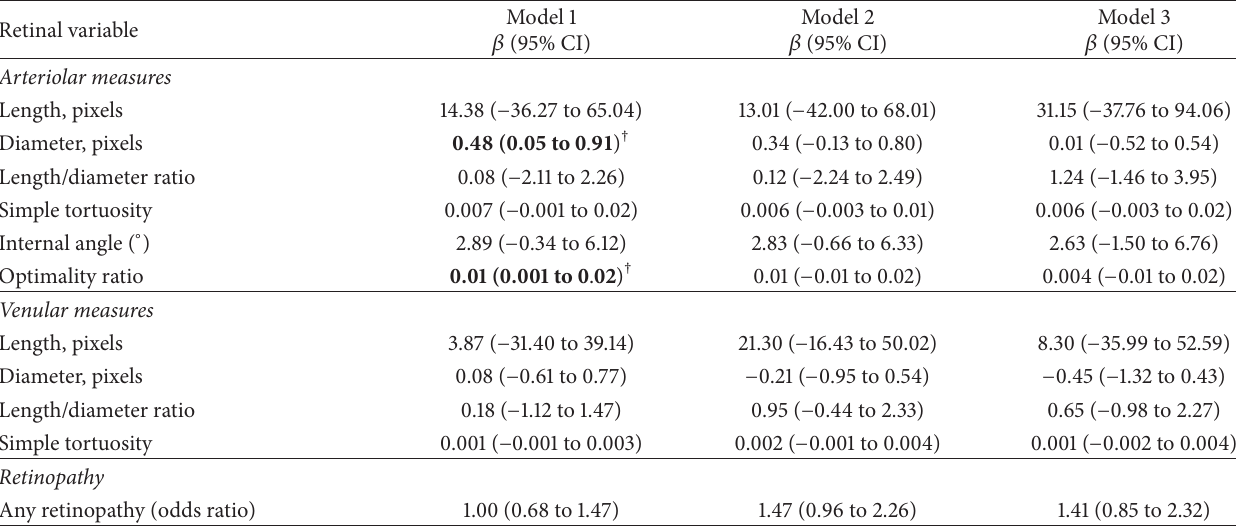
Table 2: Association between Type 2 Diabetes Mellitus and retinal measurements ∗